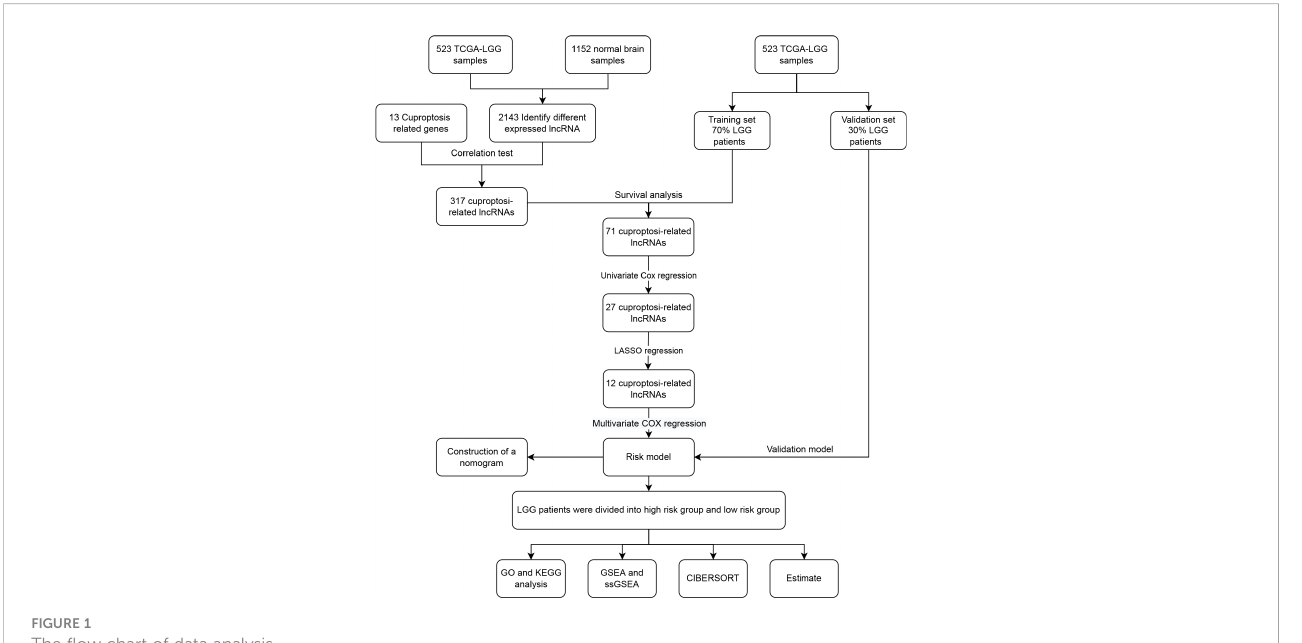
FIGURE 1 The fl ow chart of data